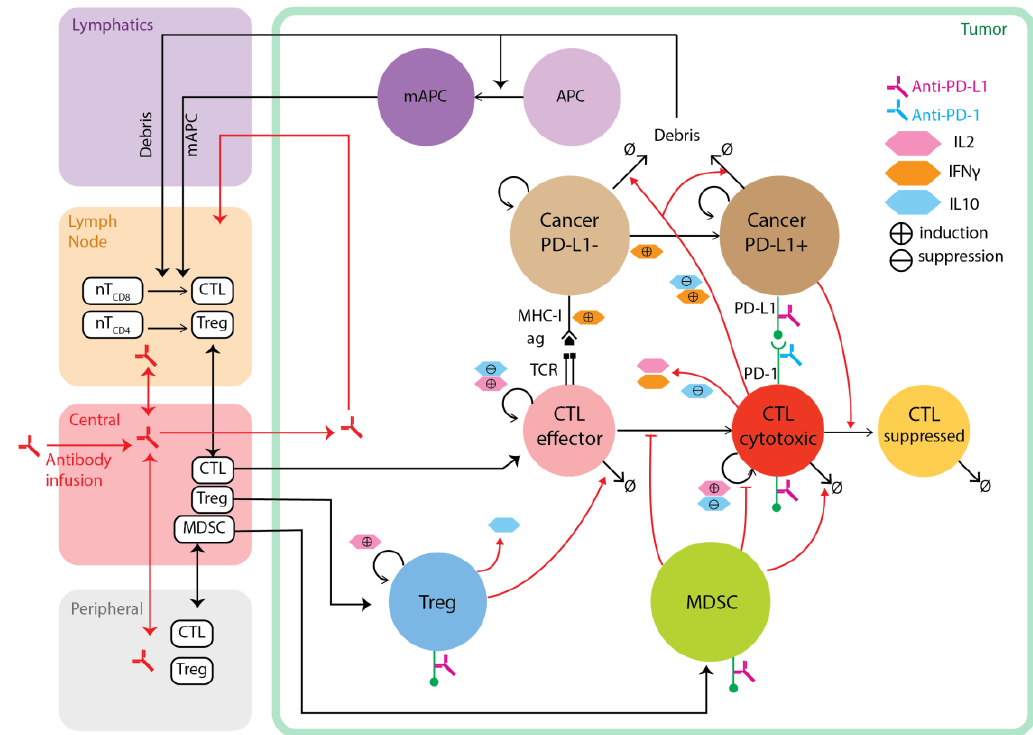
Figure 3. Diagram of a multi-compartment hybrid model capturing tumor development and anti-tumor immune response. Dynamics of cells and pharmacokinetics of drug (e.g., antibody) in the lymphatics, tumor-draining lymph node, central (blood) and peripheral compartments are modeled using ordinary differential equation systems. Spatial dynamics of cells and molecules in the tumor compartment are captured using agent-based model and partial differential equations. Death of cancer cells produces antigens which drive maturation of APC and their migration to the tumor draining LN, where CD8+ and CD4+ T-cells go through priming and proliferation before they enter blood circulation and extravasate to the tumor microenvironment. Effector CD8+ T-cells can be further activated and expanded when they encounter tumor antigens. These cytotoxic cells kill cancer cells and also release various cytokines, including IL2 which drives further proliferation of T-cells, and IFN γ which is proinflammatory and induces PD-L1 expression on cancer cells. PD-L1 can then bind to PD-1 molecules on cytotoxic T-cells, resulting in T-cell exhaustion. Both PD-L1 and PD-1 molecules are potential targets for immune checkpoint blockade antibodies. Regulatory cell types in the ABM include Treg and MDSC, which can inhibit cytotoxic T lymphocytes (CTL) through different mechanisms.